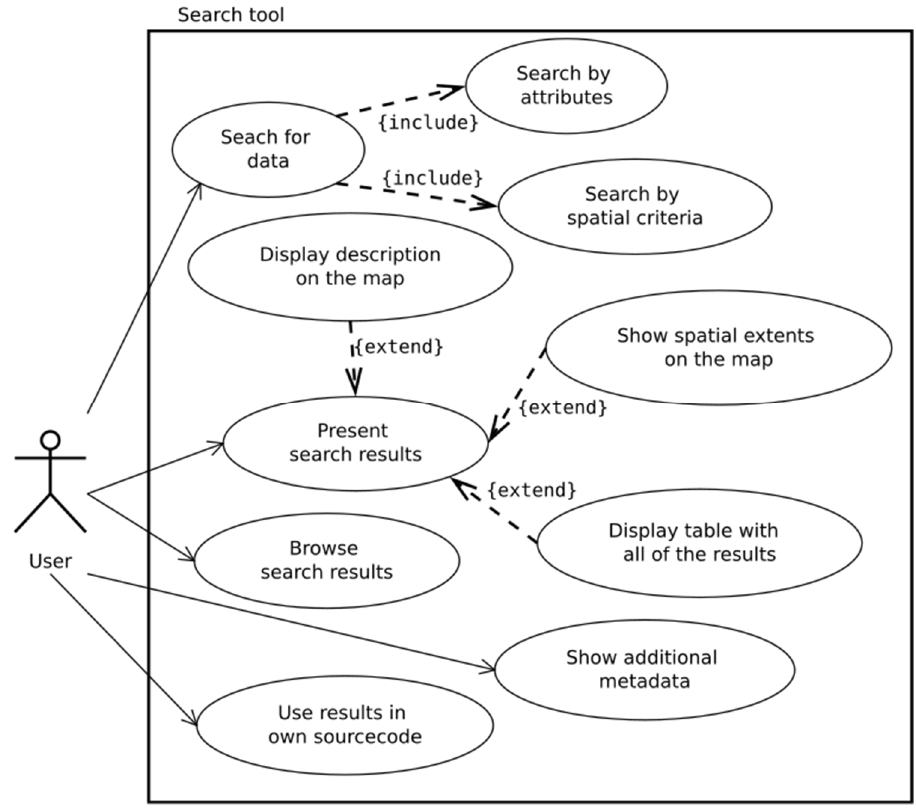
Figure 10. Earth observation (EO) data search use case diagram.